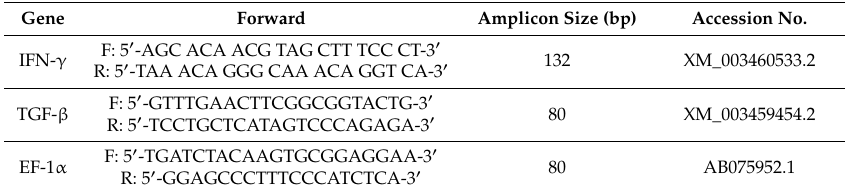
Table 1. Primer sequences used for real-time qPCR analysis of immune-related genes. Gene Forward Amplicon Size